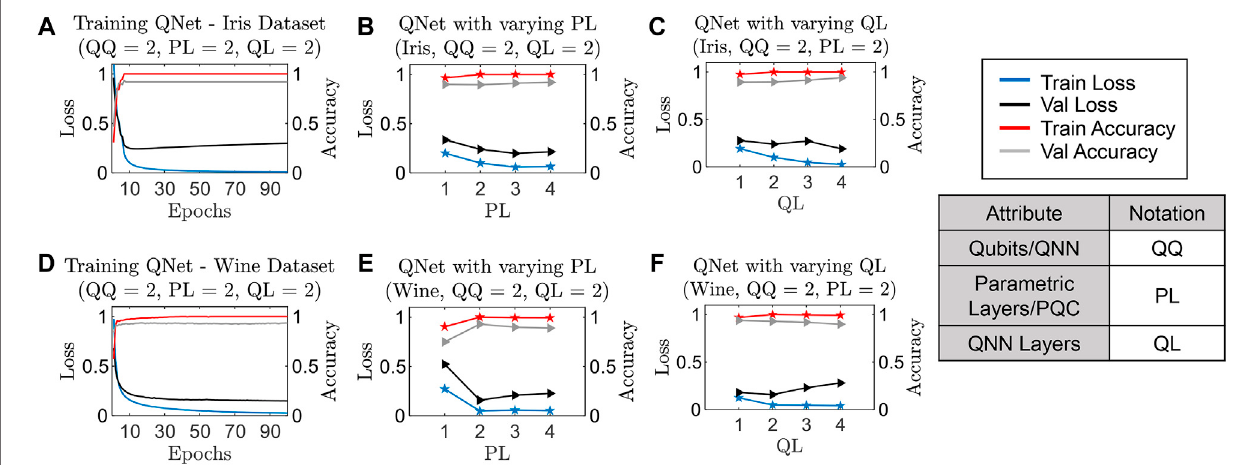
FIGURE 5 | Performance (training loss, training accuracy, validation loss, and validation accuracy) of QNet on Iris and Wine datasets with a varying number of Parametric Layers/PQC (PL) and QNN Layers (QL). Qubits/QNN (QQ) is fi xed at 2. (A,D) shows the performance over 100epochs of training. (B,E) shows performance against varying PL after 20 training epochs. (C,F) shows performance against varying QL after 20 training epochs. All data points are an average of 10 different training runs that start with different seeds. The models tend to over fi t (performance improves monotonically for the training set and worsens for the validation set) with an increasing number of epochs, PL and QL.